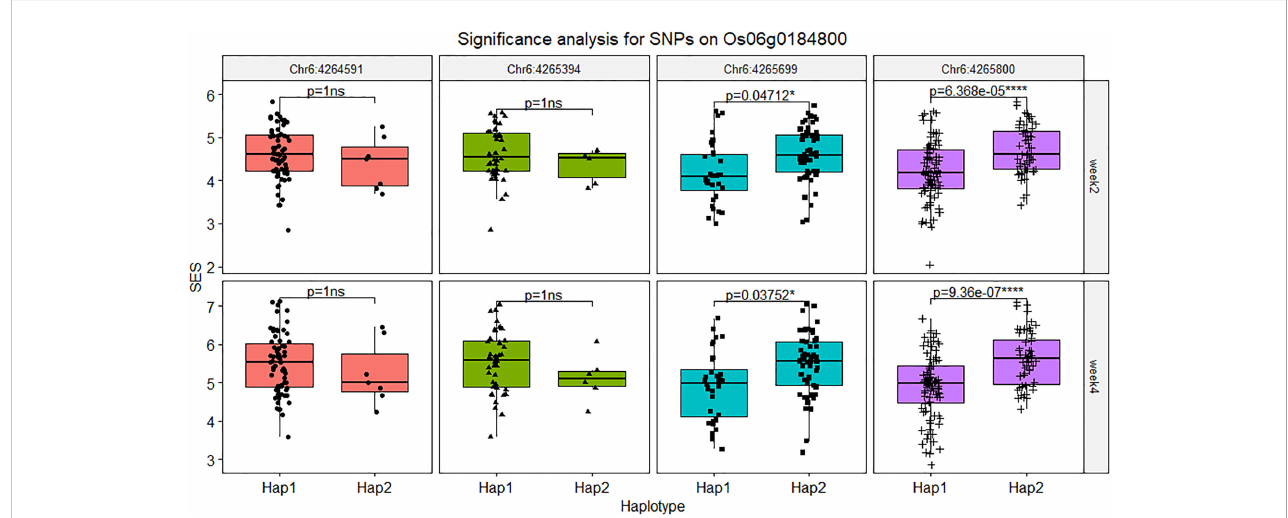
FIGURE 8 Signi fi cance analysis for SNPs on Os06g0184800 . The symbol “ ns ” indicated not reach signi fi cant difference, * indicated the level of signi fi cance reached 0.05, **** indicated the level of signi fi cance reached